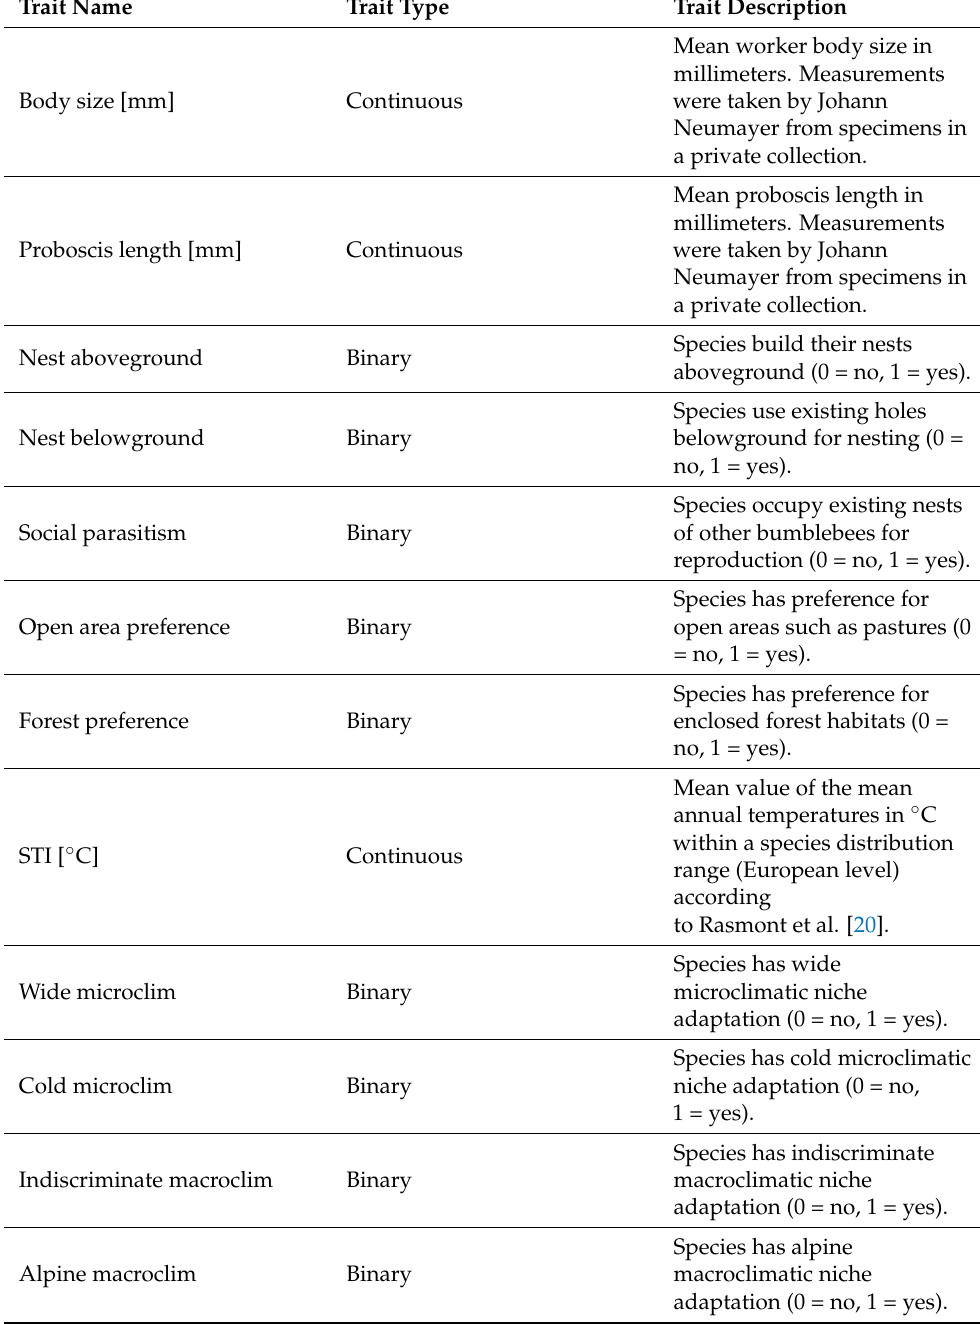
Table A2. Bumblebee species trait